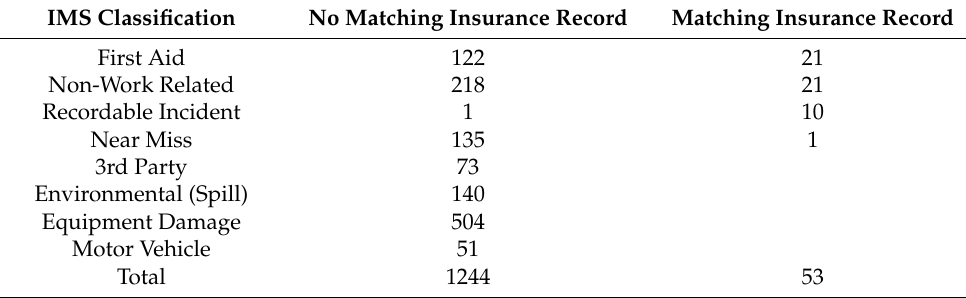
Table 1. Contingency table of insurance records and IMS classifications.